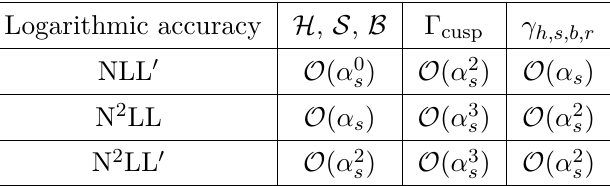
Table 1 . Precision prerequisites on the anomalous dimensions and the fixed-order functions for a given logarithmic